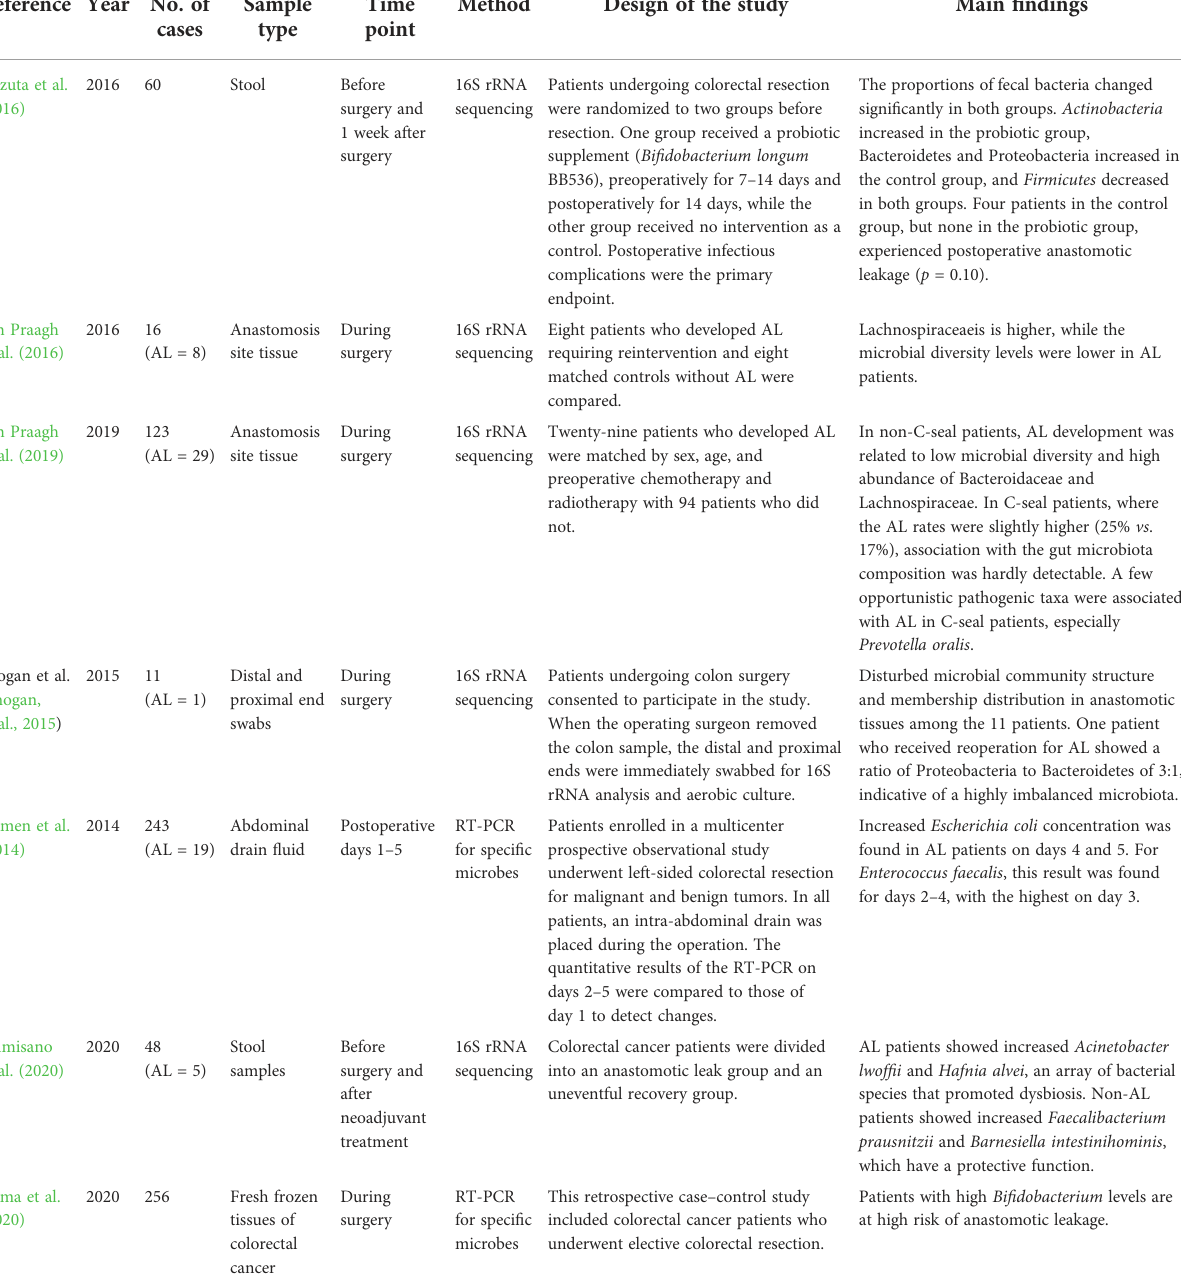
TABLE 1 Clinical investigations on the gut microbiota and anastomotic leak